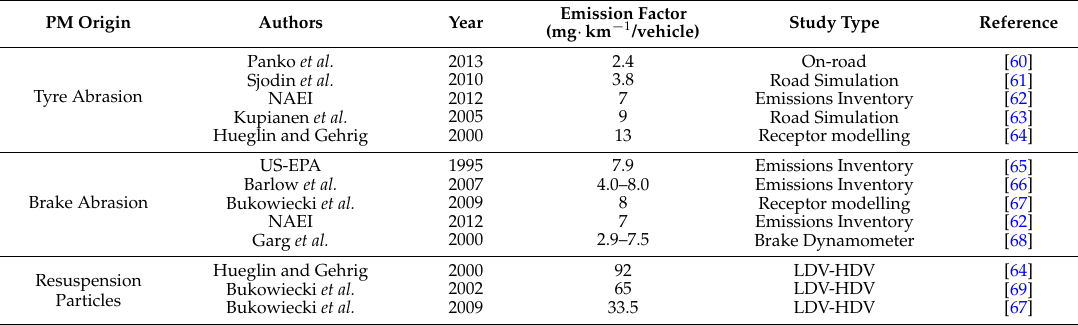
Table 6. Studies tackling abrasion-related particles in a non-exhaust context.